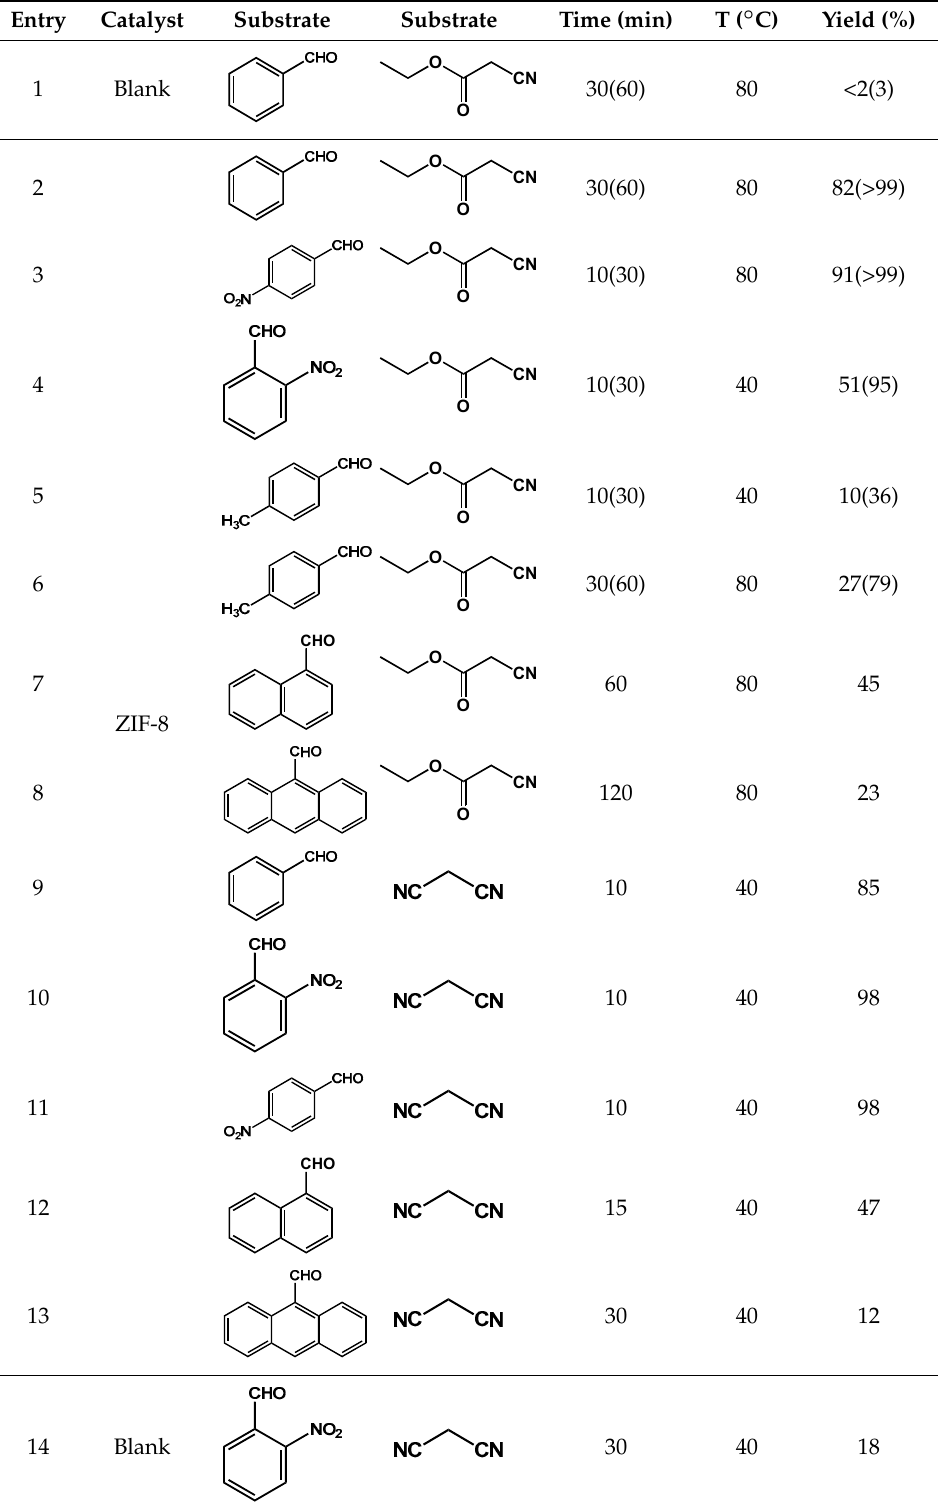
Reaction conditions: 3.5 mmol aldehyde, 4 mmol ethyl cyanoacetate or malononitrile, 25 mg ZIF-8 in